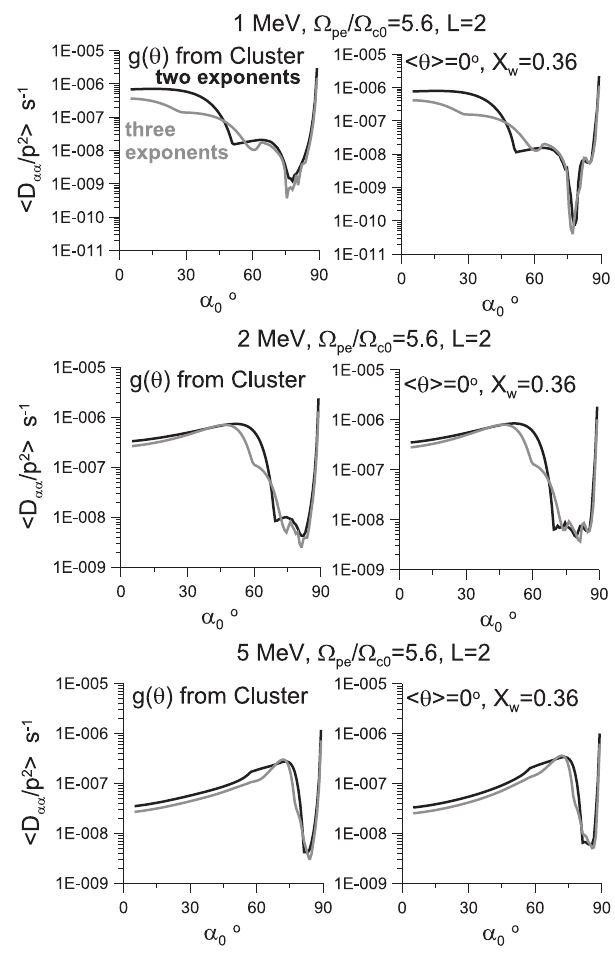
Fig. 19. h D i B for three values of electron energy ( L = 2 . 0, (cid:127) pe /(cid:127) c0 = 5 . 6). Approximation of G ω by three and two exponents are used (see text for details). Left column show data obtained with approximation of g(θ) distribution in Eq. (18). Right column shows data for parallel wave